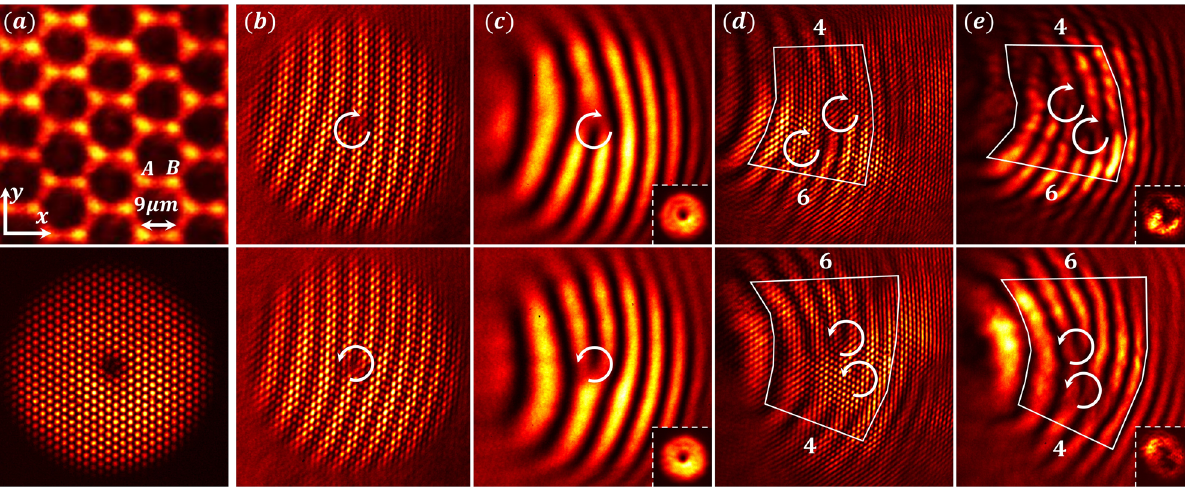
Fig. 2 Experimental demonstration of topological conversion in a pseudospin-1/2 honeycomb lattice. a Top: an optically induced HCL; Bottom: input pattern of vortex-bearing triangular lattice beam used for selective excitation of the pseudospin states. b – e Top (bottom) row corresponds to initial excitation of s = 1/2 ( s = − 1/2) pseudospin state with vortex beams of initial topological charge l = 1 ( l = − 1). Interferograms of input (b, c) and output (d, e) with a tilted reference beam showing topological charge conversion from 1 to 2 (top) and from − 1 to − 2 (bottom). b , d Interferogram from the whole beam, and ( c , e ) corresponding interferogram from one of the spectral components. Difference in the numbers of counted fringes from the two sides of the marked region illustrates the net topological charges at output in ( d , e ). White curved arrows mark the position and helicity of the vortices. Insets in ( c ) and ( e ) show singly and doubly-charged vortex intensity patterns obtained at input and output, respectively, from one of the K valleys as illustrated in Fig.